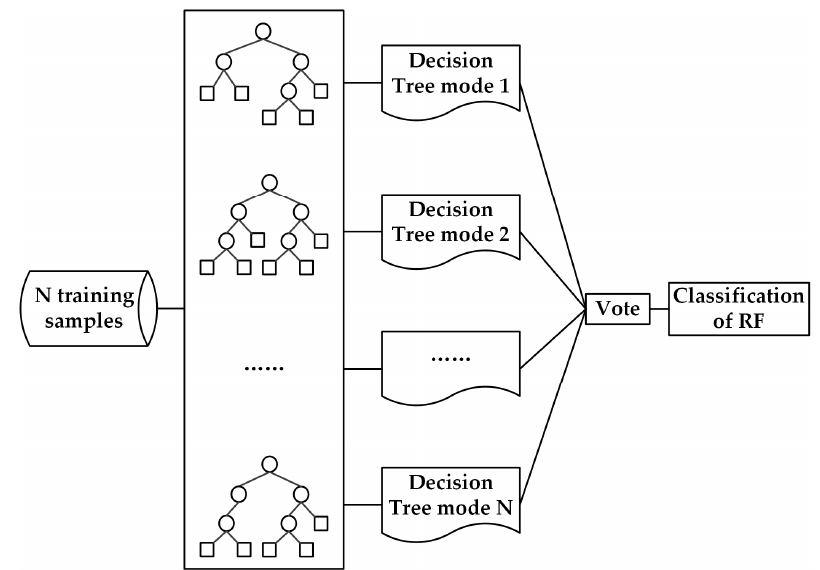
Figure 3. The flowchart of the random forest (RF) algorithm.